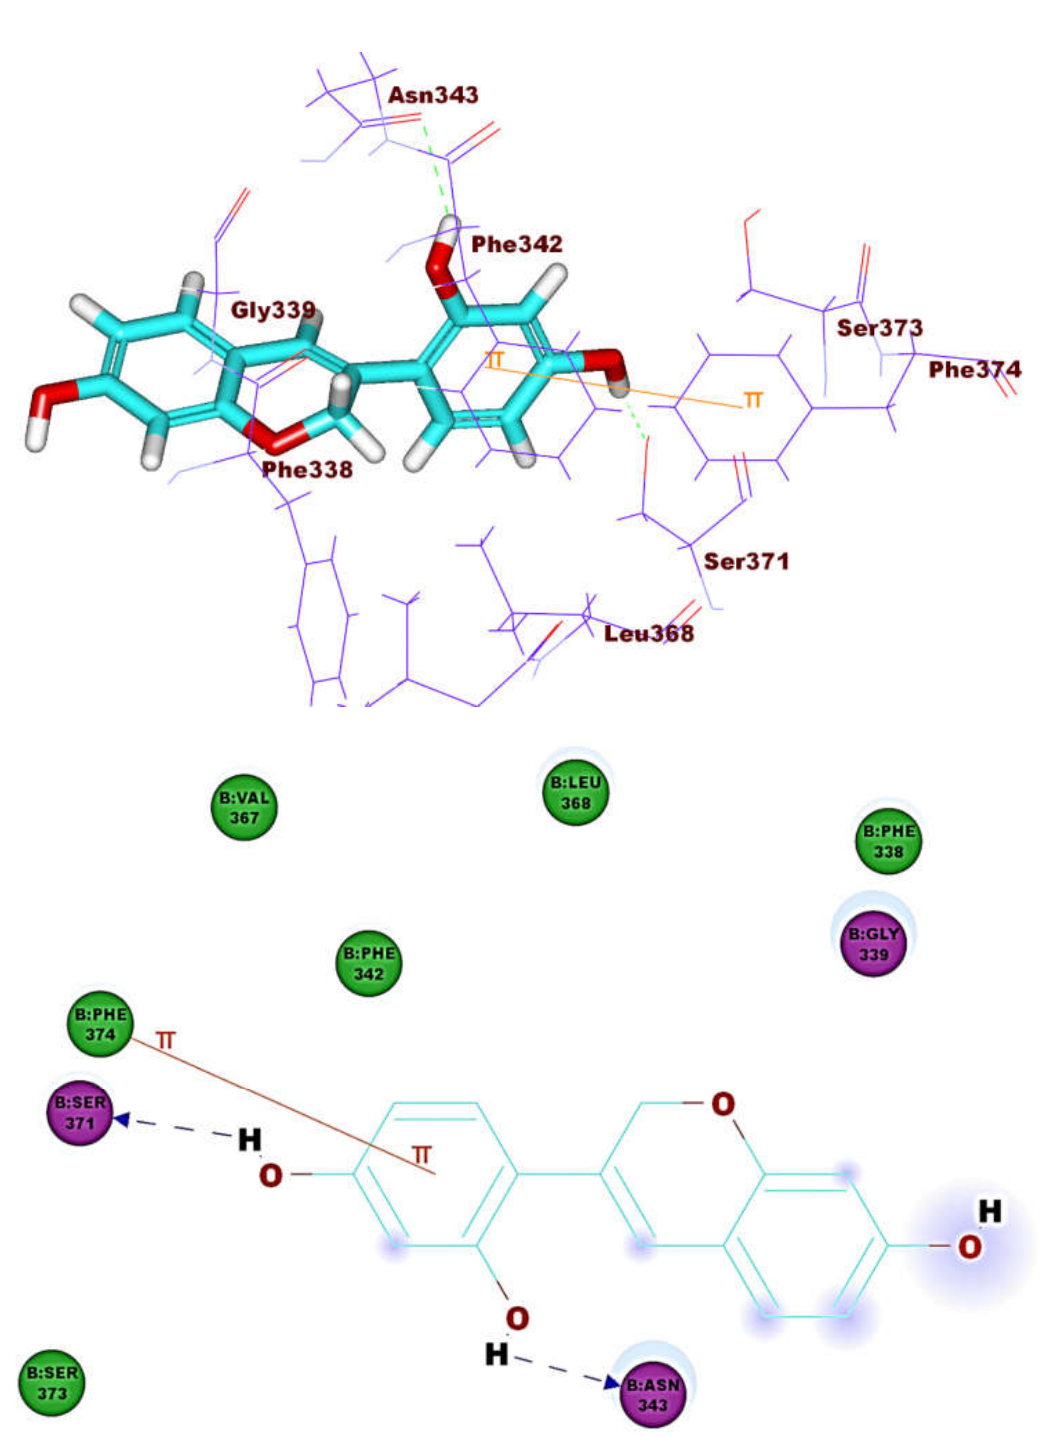
Figure 6. Comound 8 docked into ACE-2, forming two H. bonds with Ser371 and Asn343.